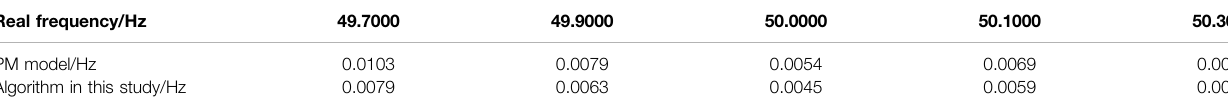
TABLE 3 | Maximum deviation of frequency measurement.